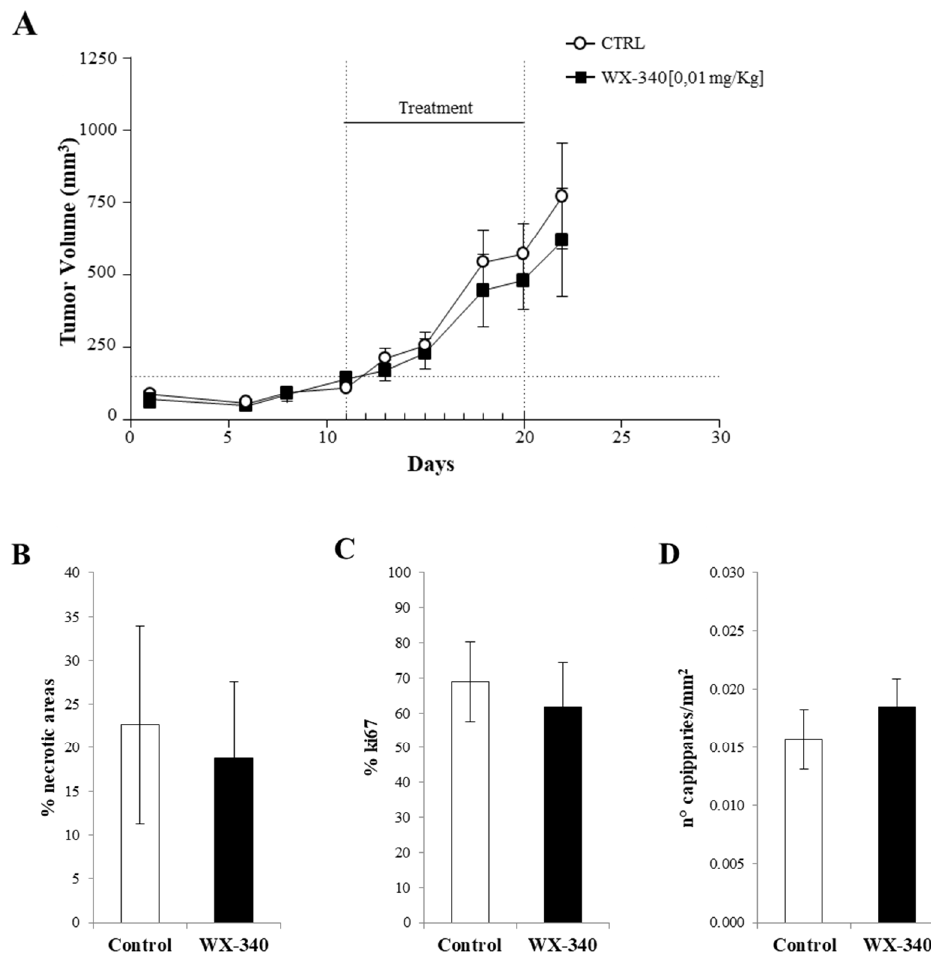
Figure 7. ( A ) Growth curves of tumor masses in ATC xenograft models. For convenience, only one group of treated mice is represented together with the control group. Quantitative analysis of necrosis ( B ), proliferation index ( C ), and vessel density ( D ) in tumor sections of treated mice vs. control mice. Results are expressed as mean ± SD.